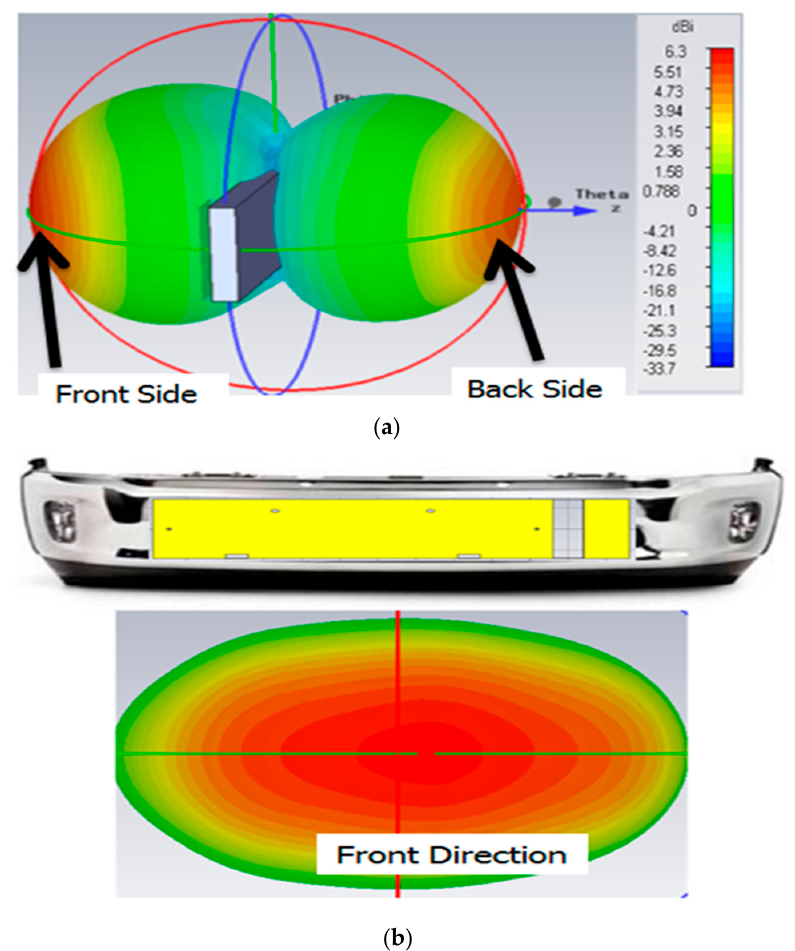
Figure 8. ( a ) Side view of 3D radiation pattern with plate holder and at 920 MHz. ( b ) Front view of radiation pattern of the tag antenna at 920 MHz.